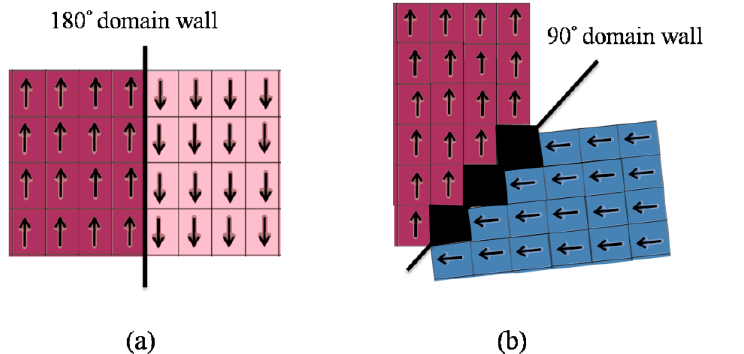
Figure 2 . (a) A 180° domain wall separating lattices with anti-parallel polarizations; (b) A 90° domain